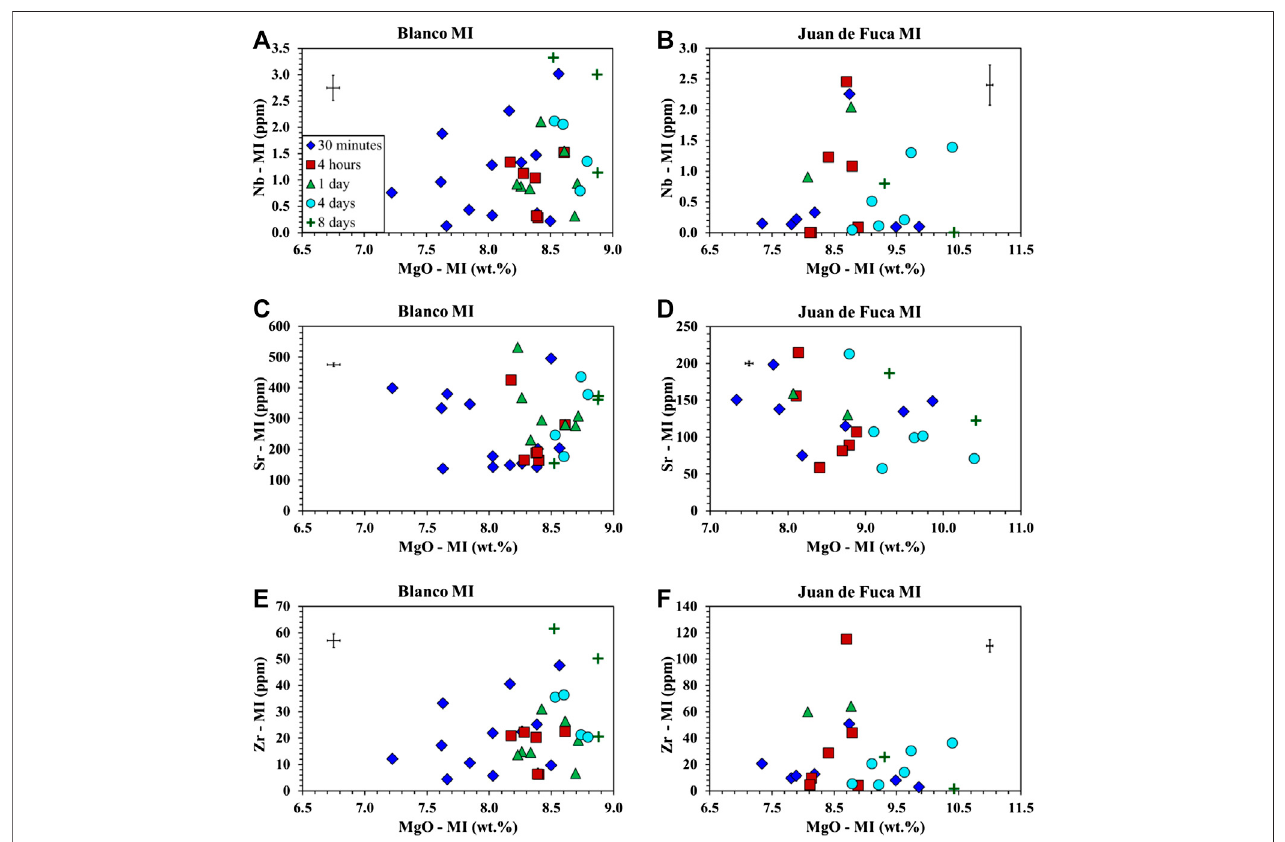
FIGURE 6 | Trace element analysis of MI following homogenization at 1 bar for samples from the Juan de Fuca Ridge (D23-2) and the Blanco Fracture Zone (A91- 1R1). Symbols as in Figure 1 . Error bars are located in the upper left or right corner of each plot. (A) Nb vs. MgO for A91-1R1 (Blanco Fracture Zone) shows no trend in NbandanincreaseinMgO. (B) Nbvs.MgOforD23-2(JuandeFuca)showsnotrendinNbandanincreaseinMgO. (C) Srvs.MgOforA91-1R1(BlancoFracture Zone) showsnotrendinSrandMgO. (D) Srvs.MgOforD23-2(JuandeFuca)showsnotrendinSrandanincreaseinMgO. (E) Zrvs.MgOforA91-1R1(BlancoFracture Zone) shows no trend in Zr and an increase in MgO with time. (F) Zr vs. MgO for D23-2 (Juan de Fuca) shows no trend in Zr and an increase in MgO with time.